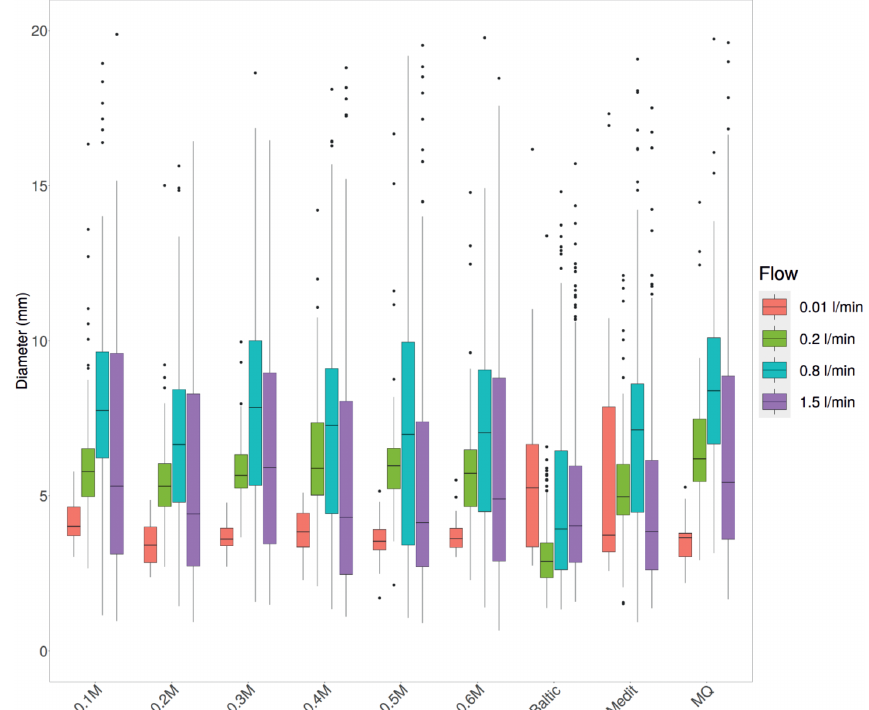
Figure 2. Bubble sizes for different flow rates and water salinities formed from the upwards-looking capillary. Boxes span over quartiles Q 1– Q 3, with medians shown as a horizontal dash. The upper whisker extends from the hinge to the highest value that is within 1.5 × IQR of the hinge ( Q 1– Q 3 distance). The lower whisker extends from the hinge to the lowest value within 1.5 × IQR of the hinge. Data beyond the end of the whiskers are considered as outliers and plotted as